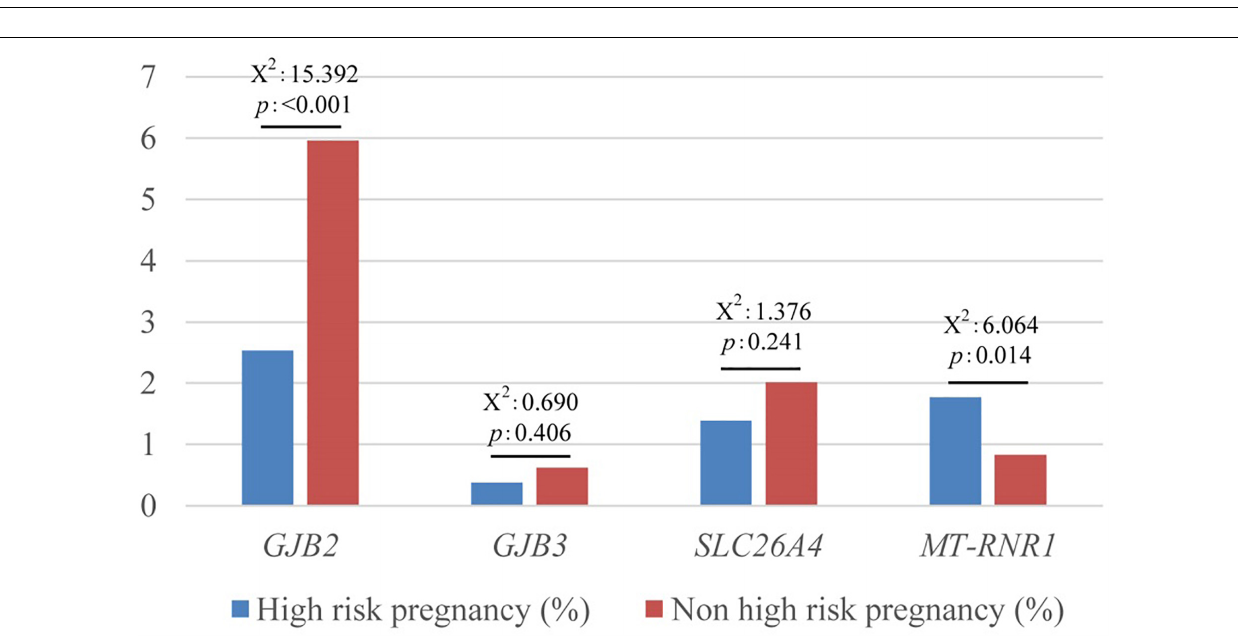
FIGURE 3 | Comparison of the positive rates of genetic screening in 12 regional hospitals of Zhejiang Province.